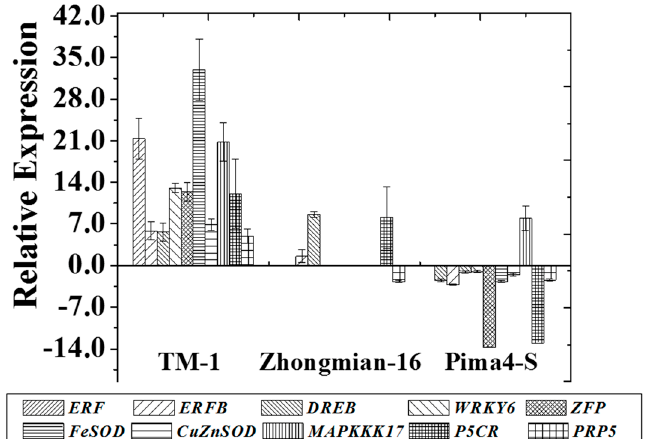
Figure 7. Effect of drought on the mRNA expression level of different drought-responsive genes, transcription factors and other regulatory proteins or enzymes controlling genes. The effects of ethylene responsive factor ( ERF ), ethylene responsive factor binding ( ERFB ), dehydration responsive element binding ( DREB ), WRKY6 , Zing finger ( ZFP ), Fe superoxide dismutase ( FeSOD ), CuZn superoxide dismutase ( CuZnSOD ), mitogen-activated protein kinase kinase kinase ( MAPKKK17 ), pyrroline-5-carboxylate reductase ( P5CR ), proline-rich protein ( PRP5 ) genes in the leaves of three cotton species TM-1, Zhongmian-16 and Pima4-S is presented. Total RNAs were extracted from leaves and subjected to reverse transcription followed by real-time PCR. The comparative threshold cycle ( C t ) method (2 −ΔΔ C t method) was used to determine the relative gene expression. EF1 α was used as an internal control. Means denoted by the same letter are not significantly different at p < 0.05. Error bars are ± SD ( n =